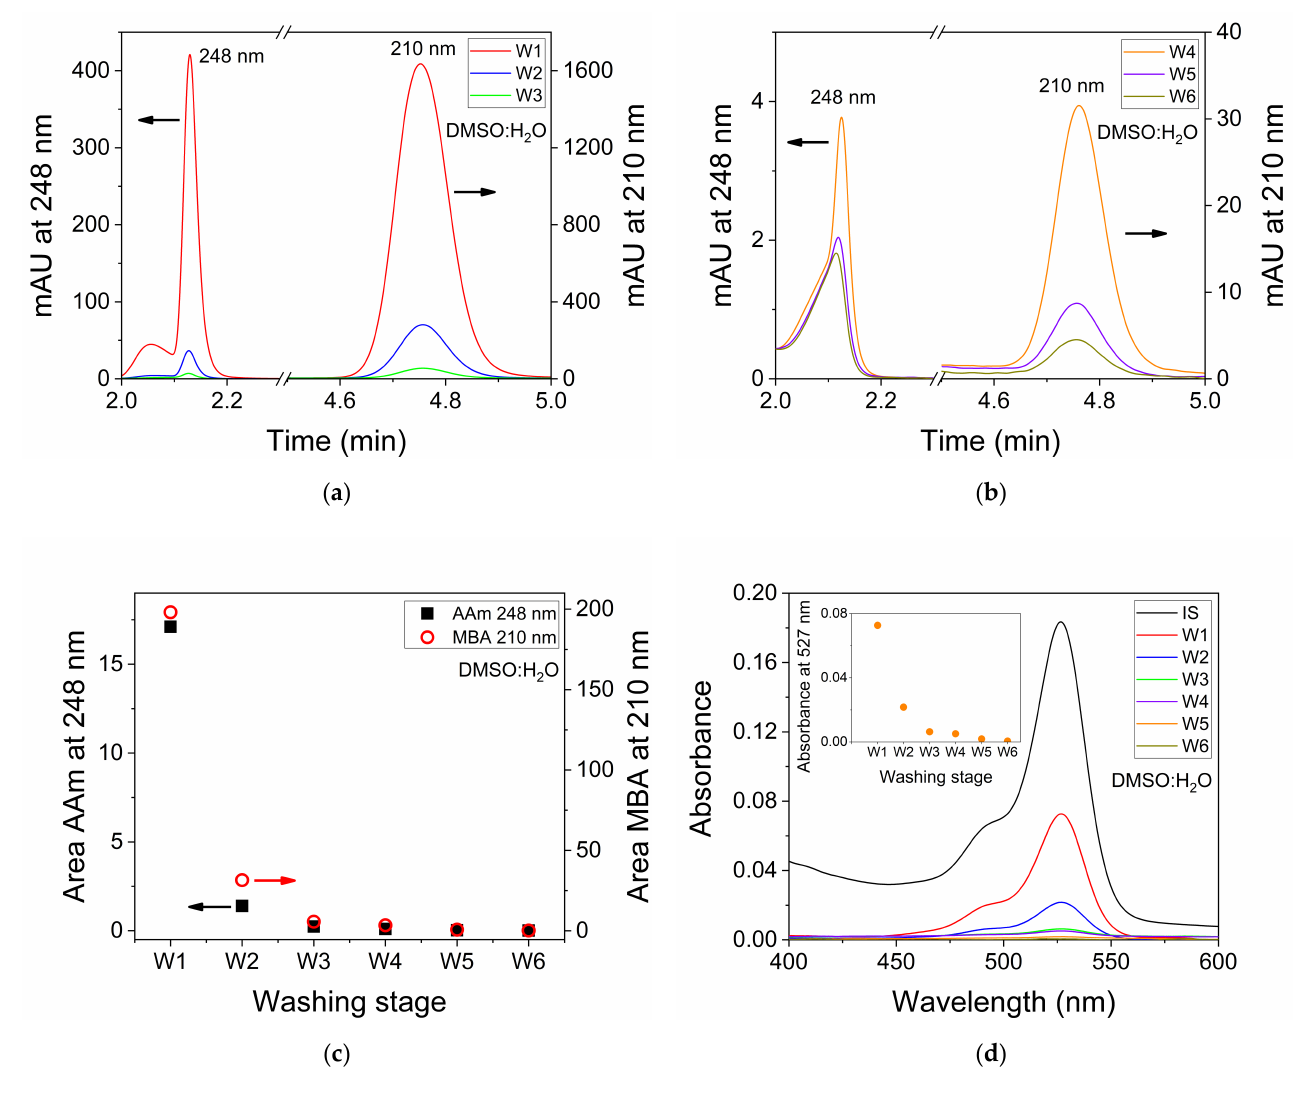
Figure 5. Chromatograms (mAU = mili OD at 210 and 248 nm) of washing solutions: ( a ) W1, W2 and W3; ( b ) W4, W5 and W6. Detection is carried out by absorption measurements at 248 nm for AAm and 210 nm for MBA; ( c ) HPLC area for AAm at 248 nm (black filled squares) and MBA at 210 nm (empty red circles); ( d ) UV-Vis absorption spectra of incubator solution and washing solutions. Inset: Absorbance at 527 nm of the washing solutions. The solvent used is DMSO:H 2 O 6:4.